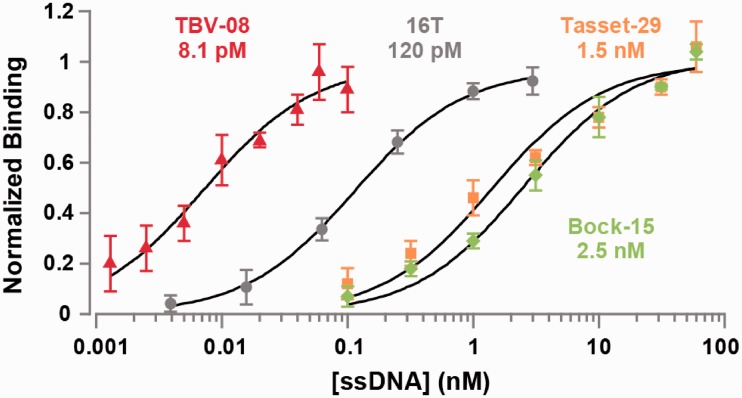
Directed evolution of an aptamer linker sequence yields significant gains in binding affinity. Normalized mean fluorescence intensities from aptamer binding assays performed in triplicate with thrombin-coated beads are shown, along with standard deviations. Our highest-affinity selected sequence (TBV-08) binds much more strongly than the parental aptamers (Bock-15 and Tasset-29) and a bivalent thrombin aptamer joined by a poly-T linker (16T). Measured apparent disassociation constants (Kds) are shown below labels.